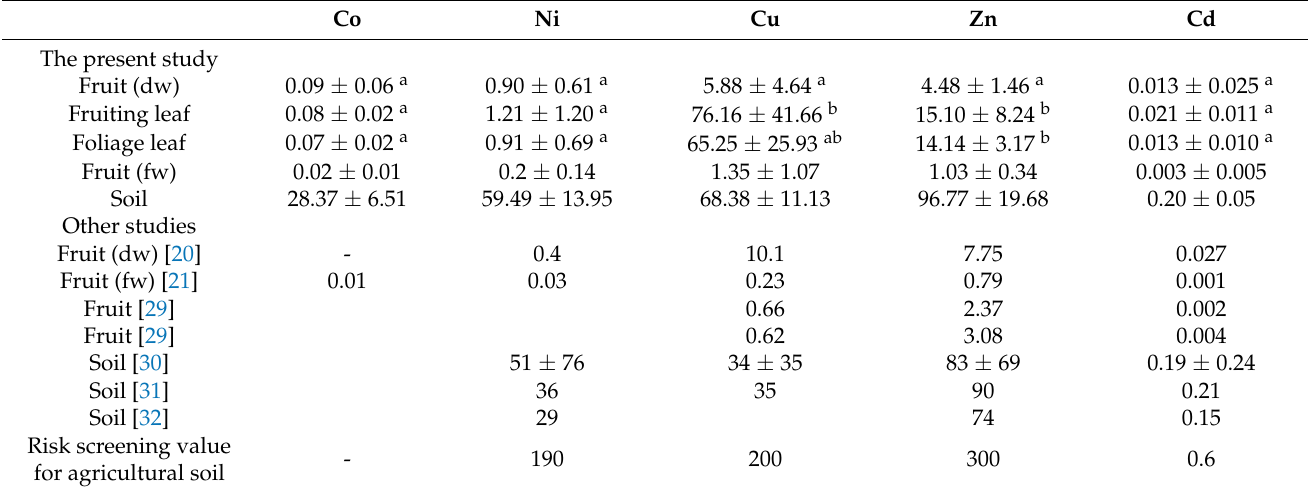
Table 2. Heavy metal mass fractions in jujube fruits, leaves and soils (mg/kg dw; Mean ±